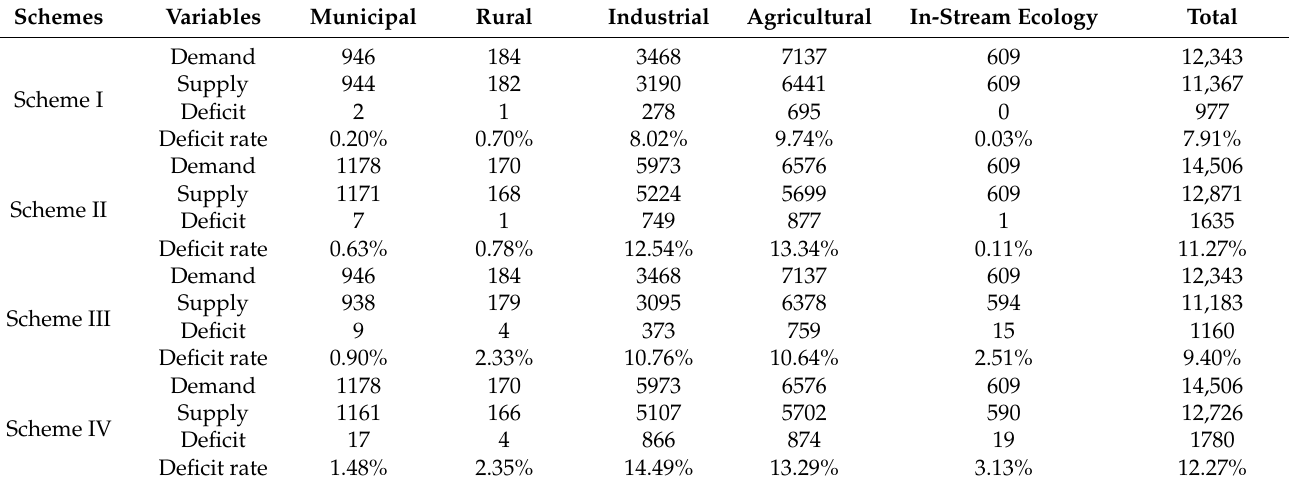
Table 6. Water resources allocation results of five types of water use (million m 3